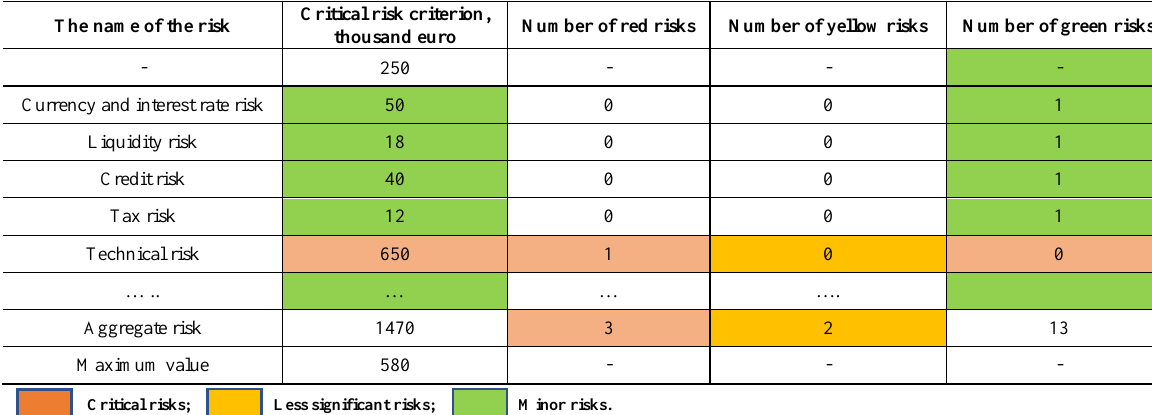
Table 3. Example of a risk